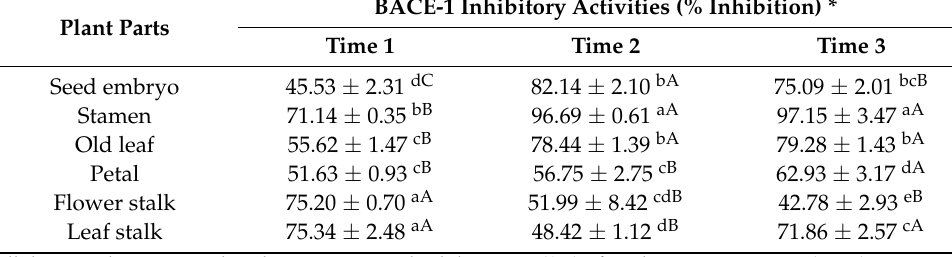
Table 5. β -Secretase (BACE-1) inhibitory activities of different sacred lotus parts collected from different time